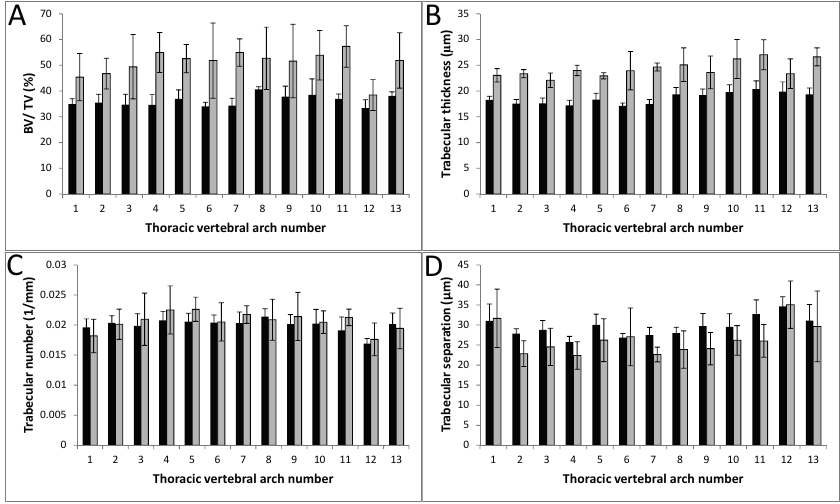
Figure 4. Densitometric analysis of vertebral arch mineralization from the thoracic region. ( A ) Percent bone volume (BV/TV) was determined for each thoracic vertebral arch and values were averaged among six wild-type and three Col11a1 − / − e17.5d embryos. Col11a1 − / − (grey) vertebral arches had a greater percent bone volume